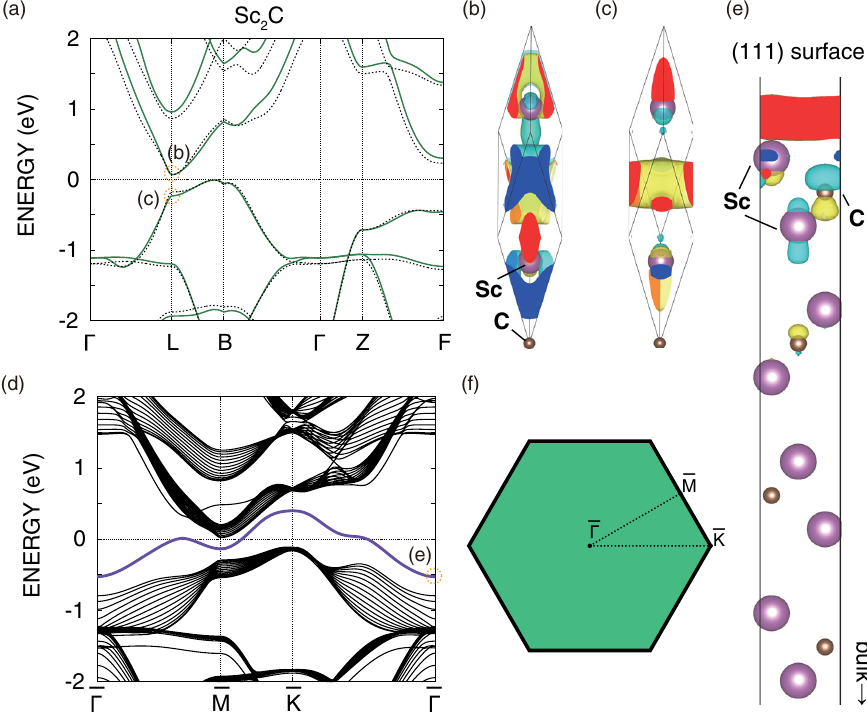
FIG. 3. Sc 2 C as an insulator with the π Zak phase. (a) Electronic band structure of Sc 2 C. The solid green line is the result in the GWA and the black dotted line is the result in the GGA þ U, where U is adjusted to reproduce the band gap of the GWA. (b),(c) Wave functions of the eigenstates at the bottom of the conduction band and at the top of the valence band at the L point, respectively. The corresponding points are indicated by the dotted circles in (a). The yellow and light blue represent the positive and negative components of the wave function, respectively, and the red and navy blue represent their cross sections, respectively. (d) Electronic band structure for the (111) surface of a slab of Sc 2 C in the GGA þ U. The purple band represents the topological surface state originating from the ¯ Γ quantized π Zak phase. (e) Wave function of the topological surface state at the point. The corresponding point is indicated by the dotted circle in (d). (f) Dependence of the Zak phase on the surface momentum k k . The shaded region represents k k with the π Zak phase. In contrast with Fig. 2(c), the Zak phase is π for the entire two-dimensional Brillouin zone. The energy is measured from the Fermi